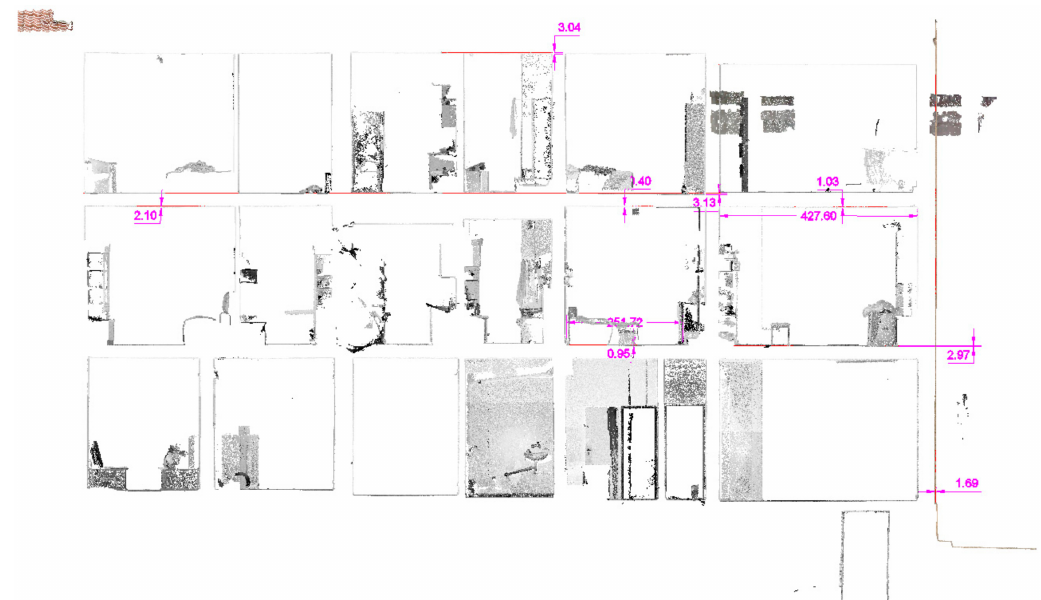
Figure 12. Internal view of the building made using TLS in Autocad 2015—cross-section with visible deformations